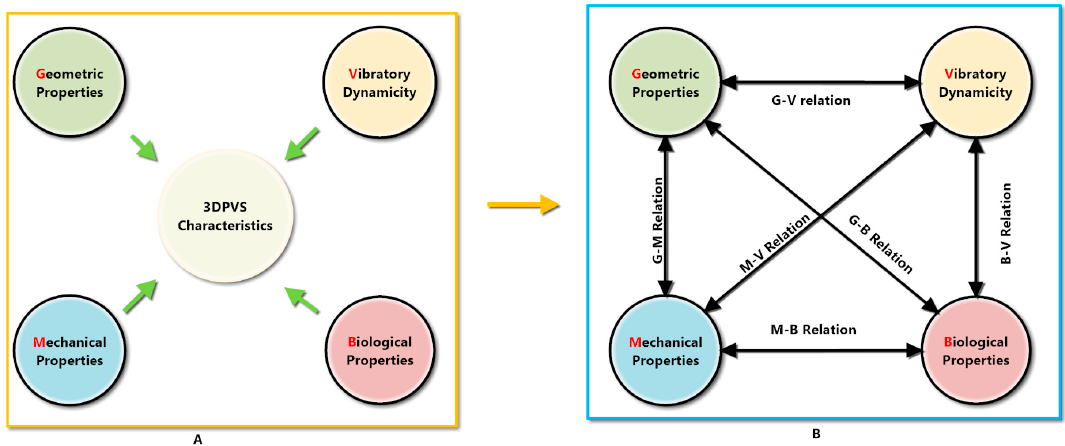
Figure 7. Four characteristics in 3DPVS design ( A ), and pairs of relationships regarding 3DPVS ideality modeling ( B ).